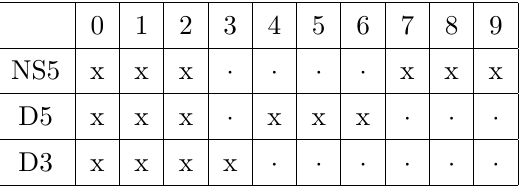
Table 4 . Basic Type IIB brane